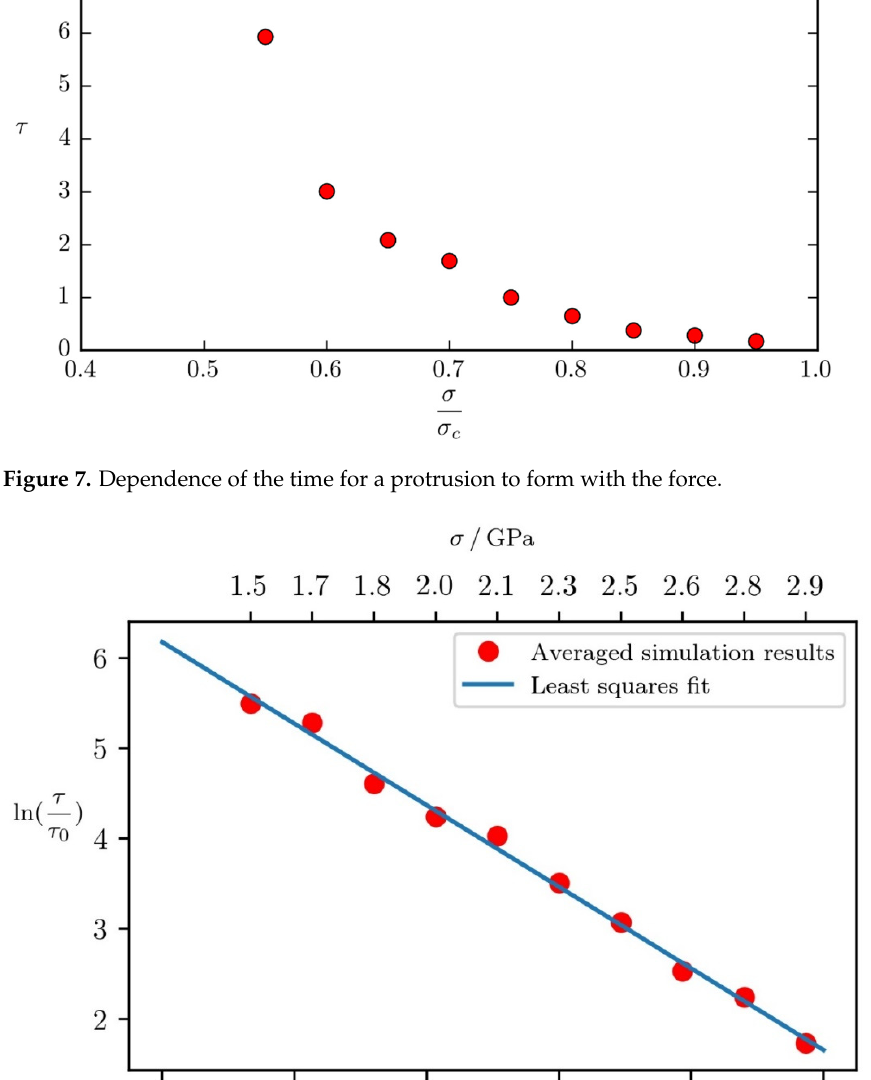
Figure 7. Dependence of the time for a protrusion to form with the force.